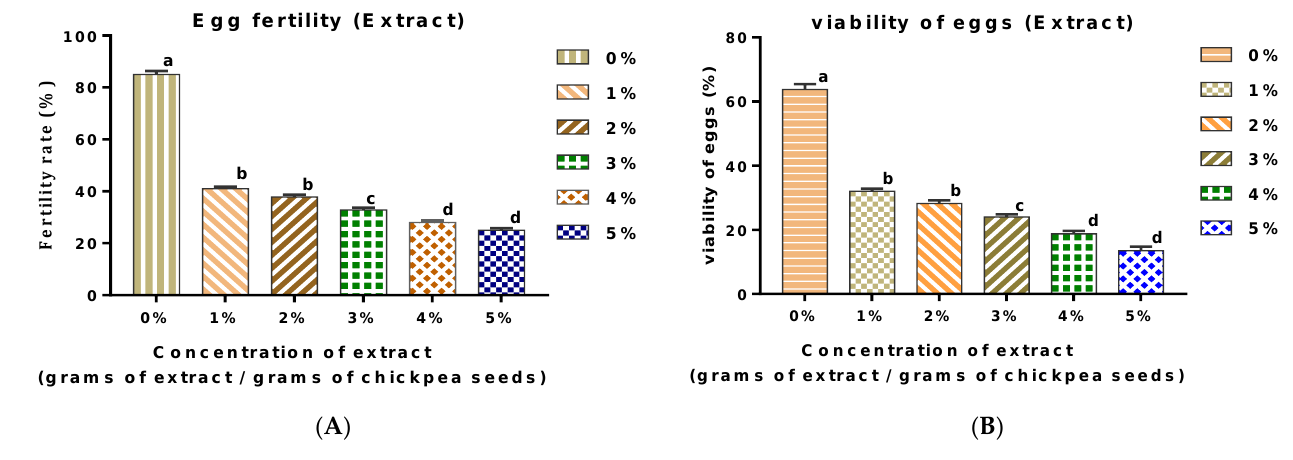
Figure 5. Effect of Withania adpressa Coss. ex Batt hydroethanol extract on Callosobruchus maculatus. ( A ) Average hatching rate of insect eggs after treatment with hydroethanol extract. ( B ) Average viability rate of eggs after treatment with hydroethanol extract. Column values with the same letters are not significantly different ( n = 3, ANOVA, Tukey ’ s HSD, p -value less than 0.05 considered to be significant).